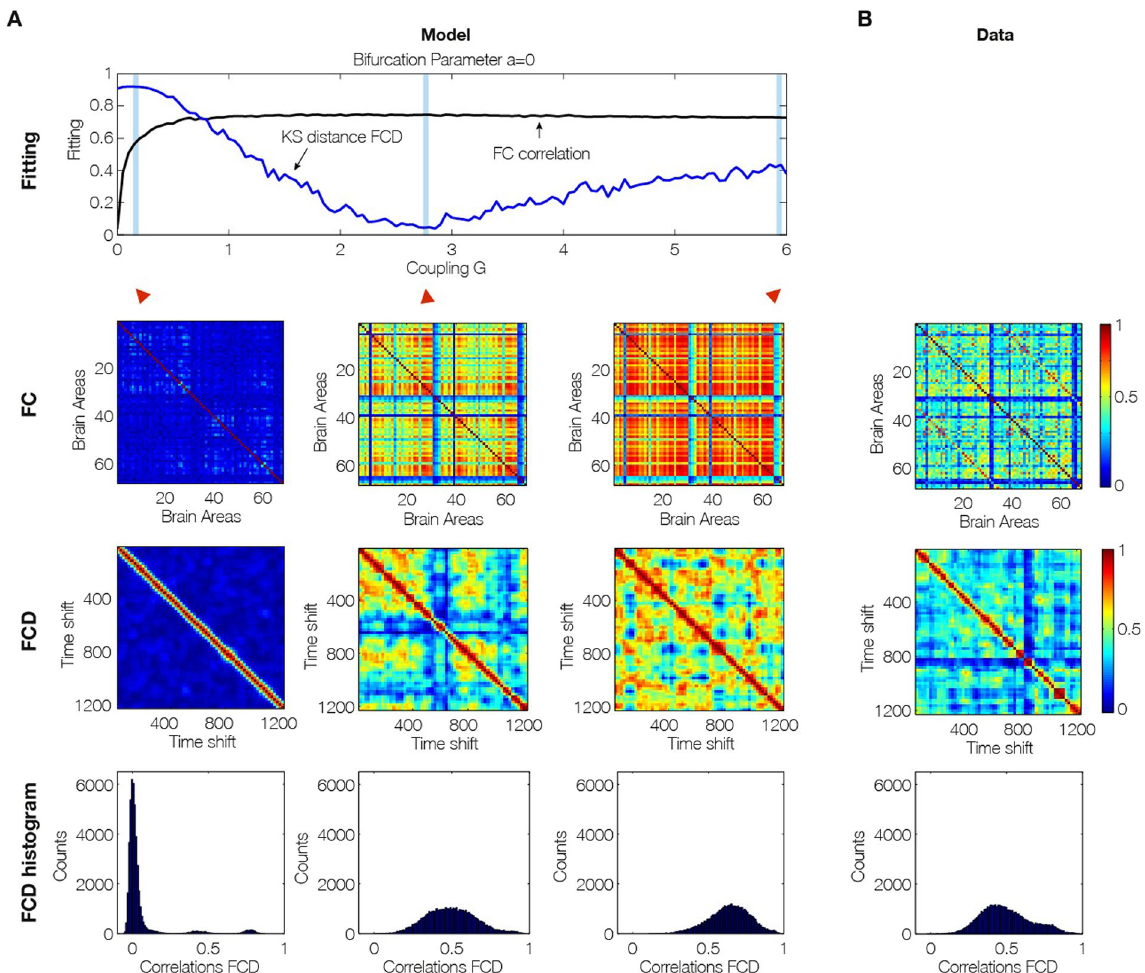
Figure 4. Fitting to the grand average FC is a necessary but not sufficient condition for best empirical fitting. ( A ) The figure shows the result of fitting the model to the empirical as a function of the global coupling parameter, G, at the optimal working point at the edge of the Hopf bifurcation (i.e. bifurcation parameter a = 0). Three different coupling points were selected (low, optimal and large in the three columns) and we show the resulting FC correlation, FCD correlations and FCD histogram. Note that for low G the FCD statistics does not show any switching between RSN and that for very large G there are too much switching between states. ( B ) For comparison, the same matrices and distributions are plotted for the empirical data. Note how only the FCD (row 2) and its statistics (row 3) are constraining enough for optimizing the working point the model to fit the empirical data (compare the distributions in row 3 and compare plots for FCD and FC fitting in row